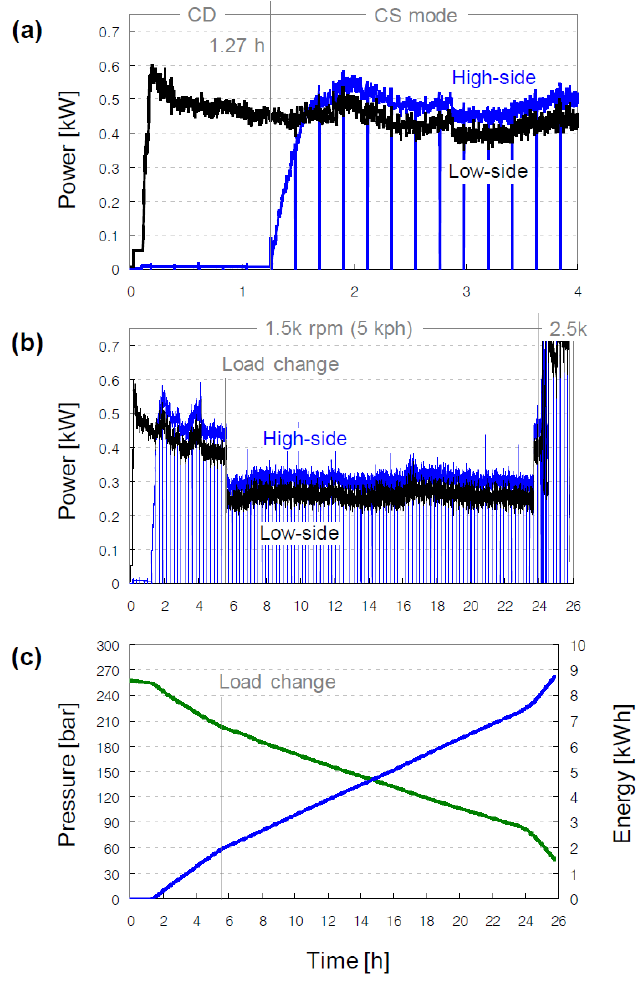
Figure 5. Results of integration tests performed to verify an extended hours of operation based on the plug-in hybrid structure. ( a , b ) Power and ( c ) Pressure with Energy versus